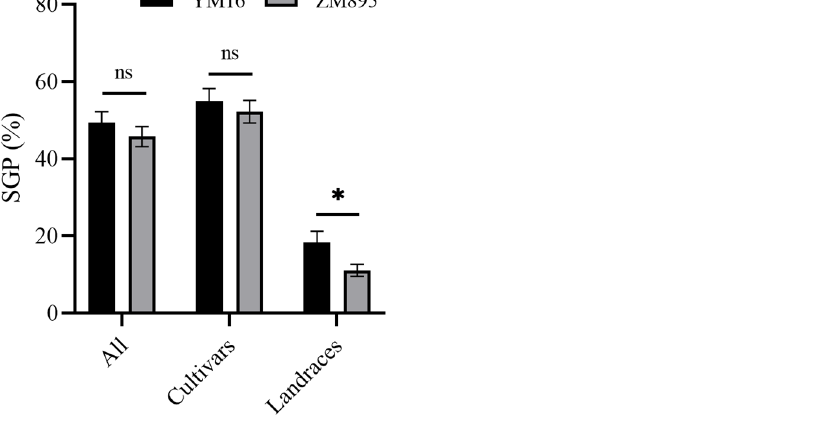
Figure 4. Effect of Qdor.hzau-3D.2 on spike germination percentage in wheat natural population. YM16, wheat varieties carrying the C allele; ZM895, wheat varieties carrying the T allele; * p < 0.05; ns, nonsignificant.